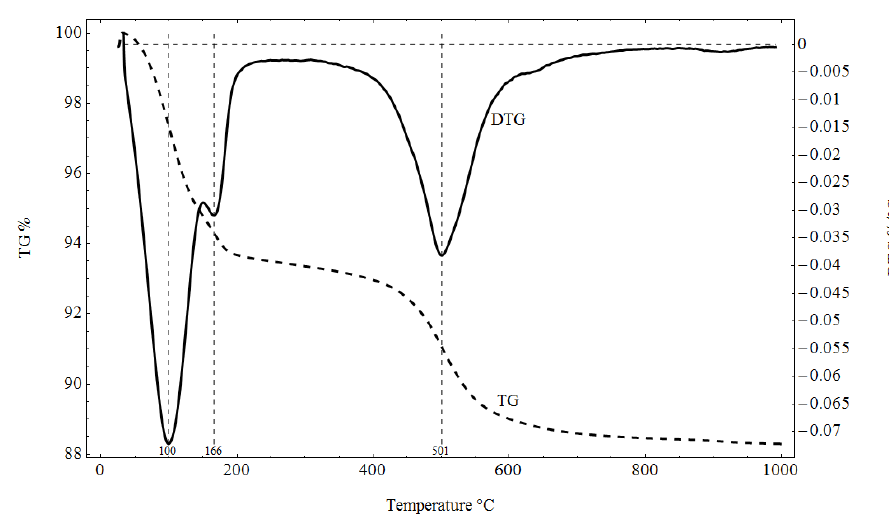
Figure 4. TG/DTG analysis results for the tested material.